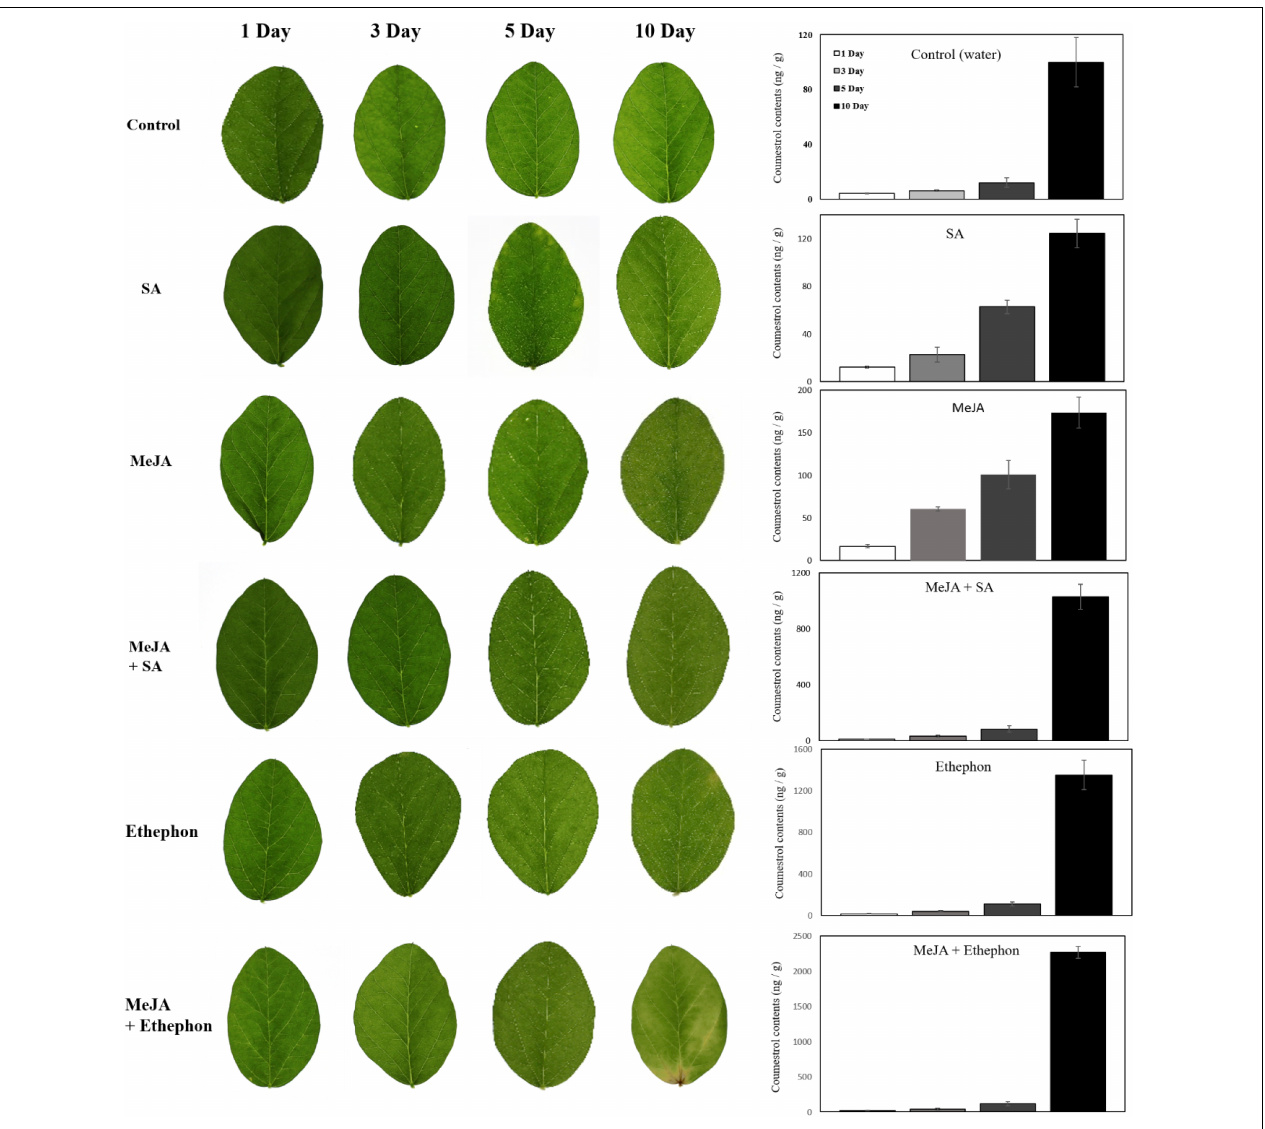
FIGURE 4 | Effects of various phytohormones on soybean leaves and endogenous coumestrol content. Leaf chlorosis was observed after 5–10 days of phytohormone application and the graph at the right side shows concomitant increase in coumestrol contents after phytohormone application at different